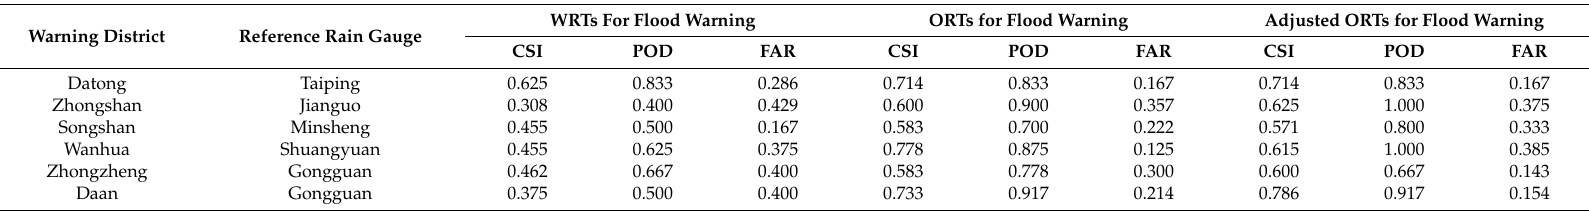
Table 6. Performance of the ORTs, adjusted ORTs and WRTs evaluated in terms of probability of detection (POD), false alarm ratio (FAR) and critical success index